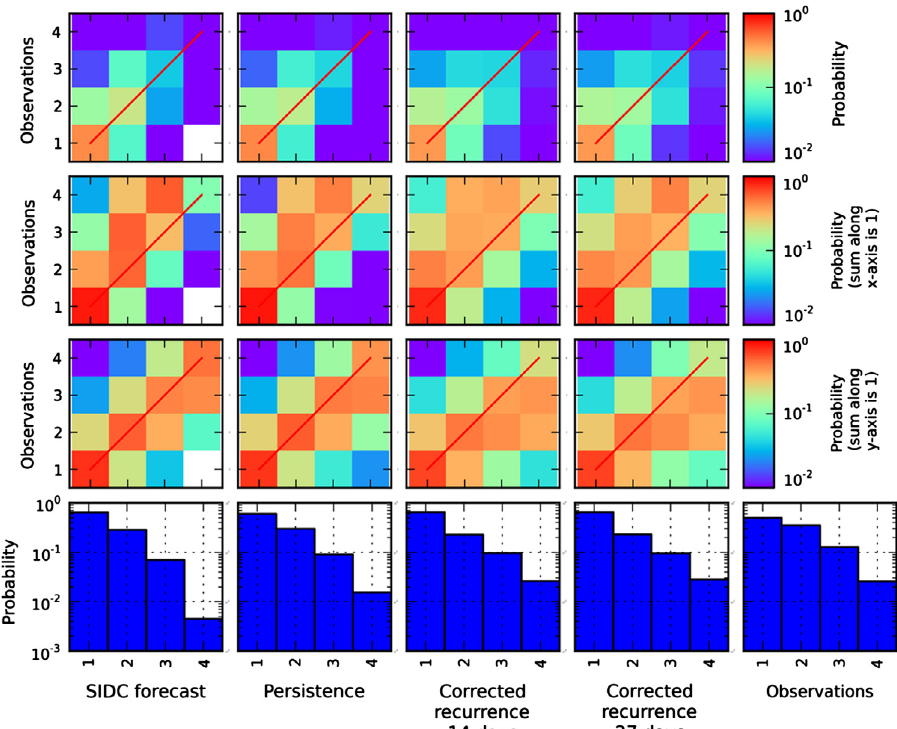
Fig. 4. Matrix plot with the distributions and color grid for the different forecast models of the flare probabilities. Top panel : color grid for the different forecasts (SIDC, persistence, corrected recurrence of 14 and 27 days). The predicted flare level is on the horizontal axis ( x -axis), while the observed one is on the vertical axis ( y -axis). The more greenish or reddish the colored square, the more frequent the combination of forecasted and observed flare level occurs. Renormalized version where the sum of the probabilities across the whole grid is 1. The color code on a logarithmic scale is shown on the right side of the panel. Second panel : similar as top panel. Renormalized version where the sum of the probabilities along the x -axis is 1. Third panel : similar as top panel. Renormalized version where the sum of the probabilities along the y -axis is 1. Bottom panel : histograms of the different forecast models and observations on a logarithmic